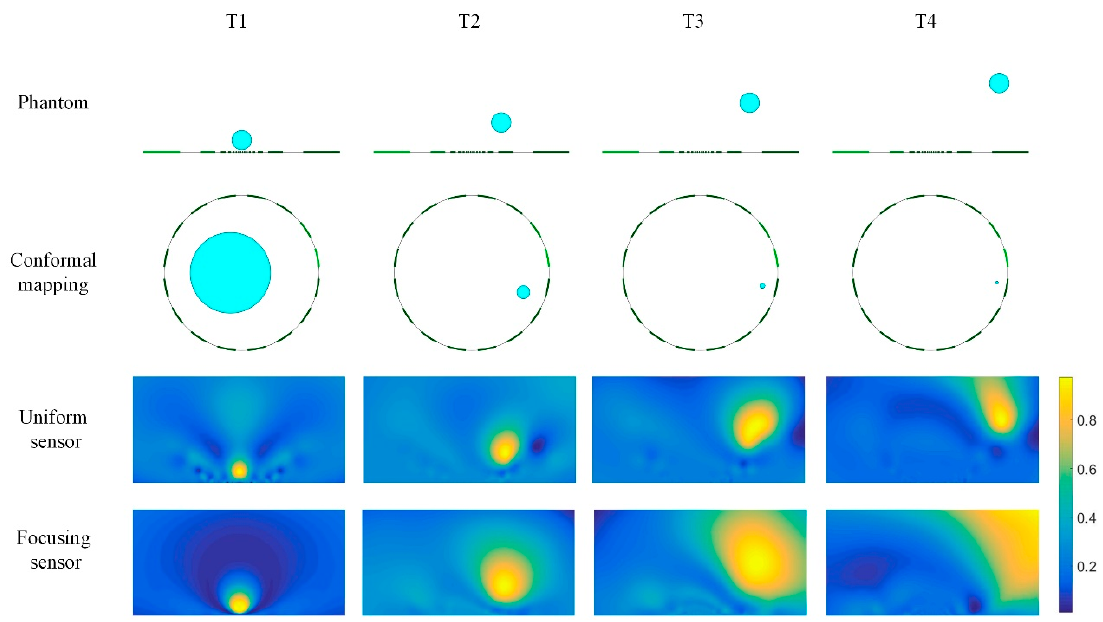
Figure 11. Reconstruction results of single target based on uniform and focusing sensors.